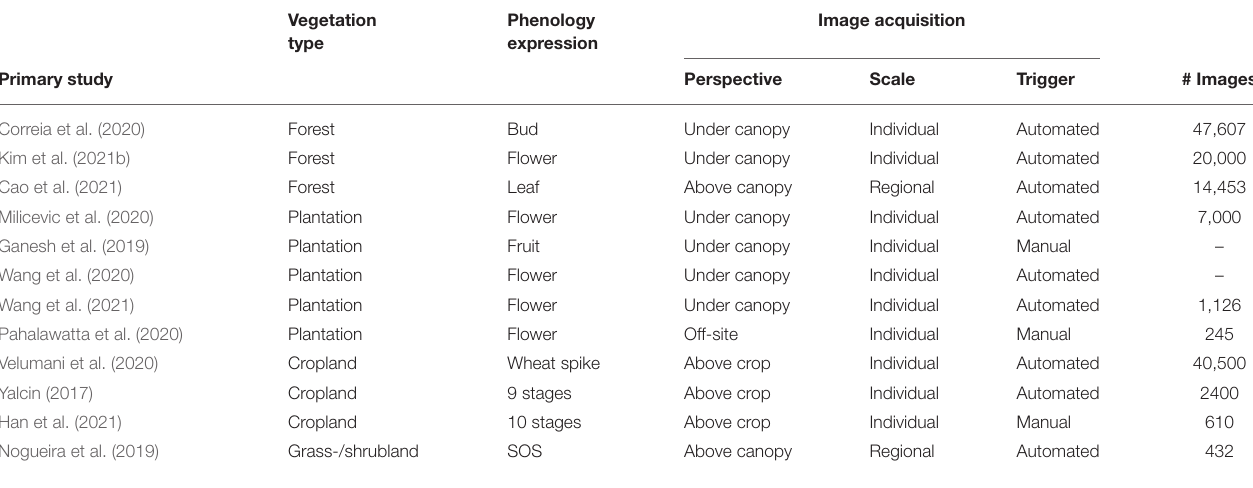
TABLE 1 | Overview of studies used digital repeat photography for phenological study with DL